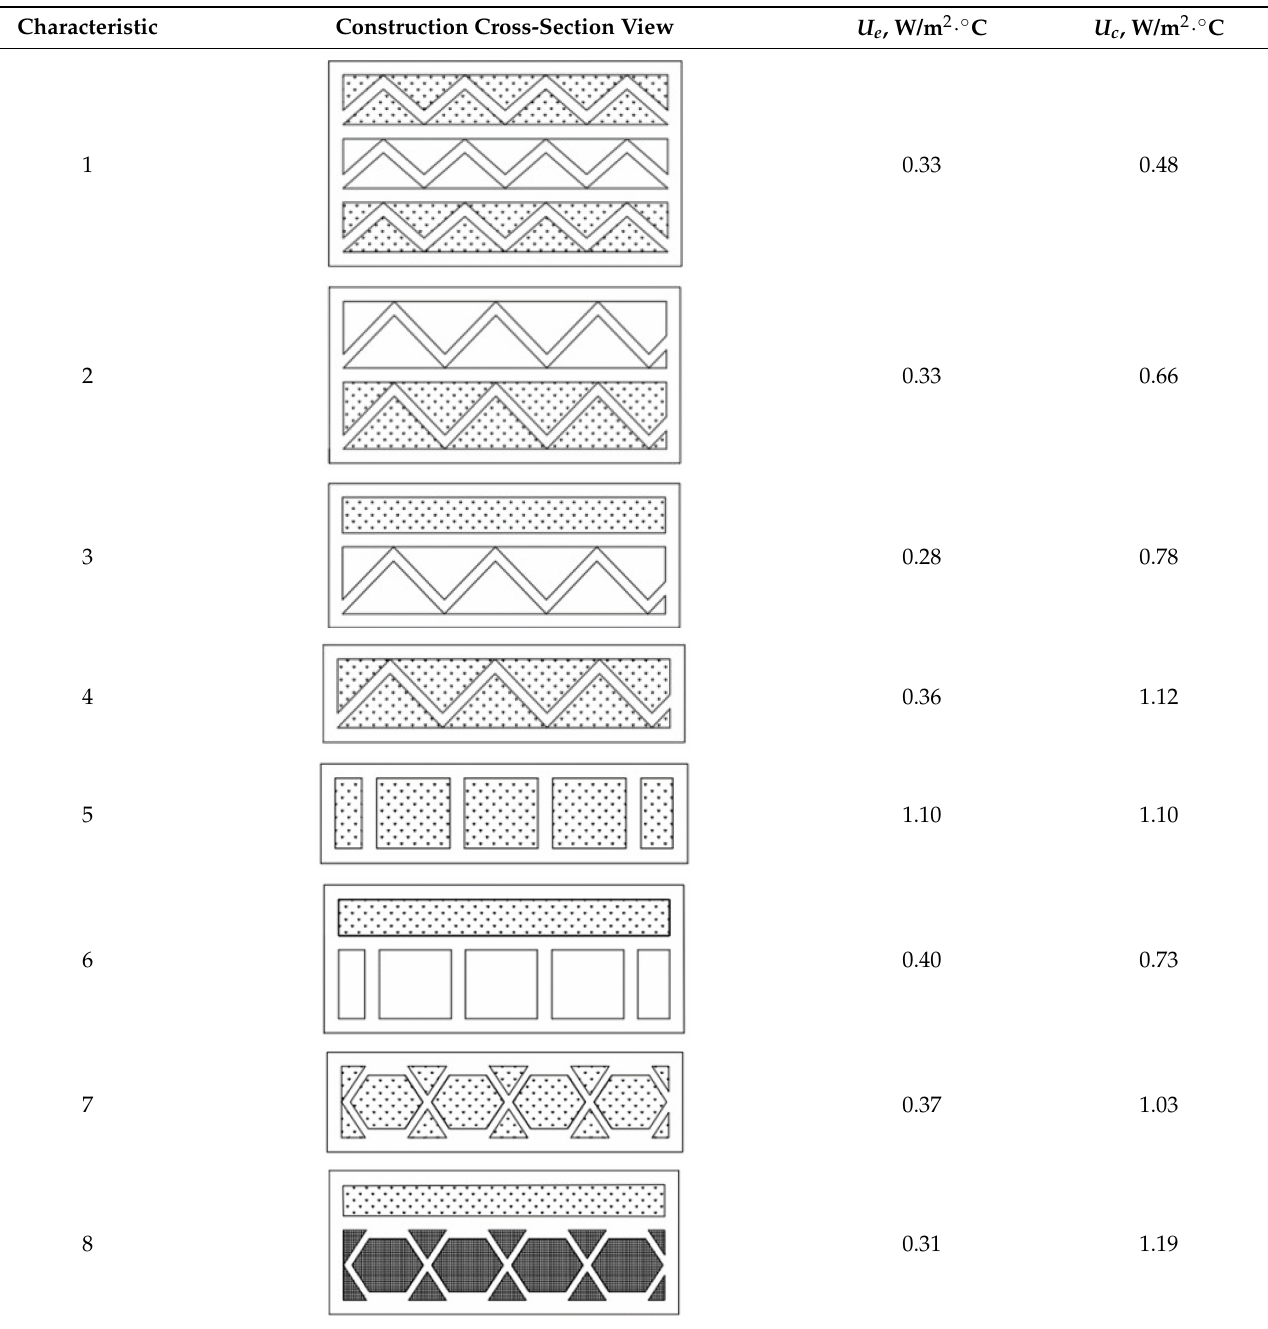
Table 8. Thermal transmittance U-values of 3D-printed constructions with different configurations and types of